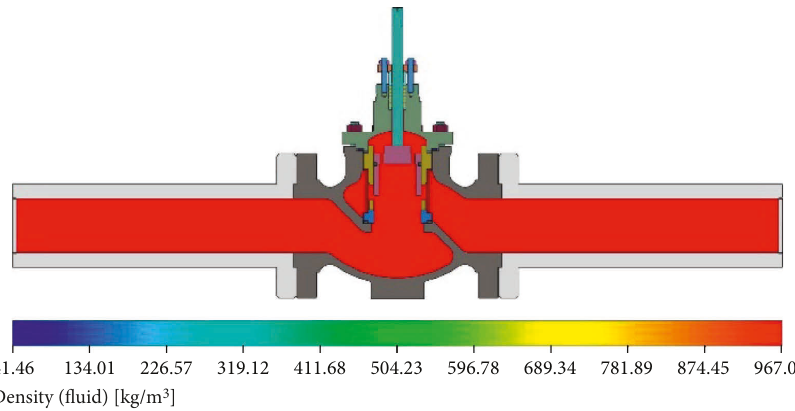
Figure 30: Fluid density cloud map for 60% opening.